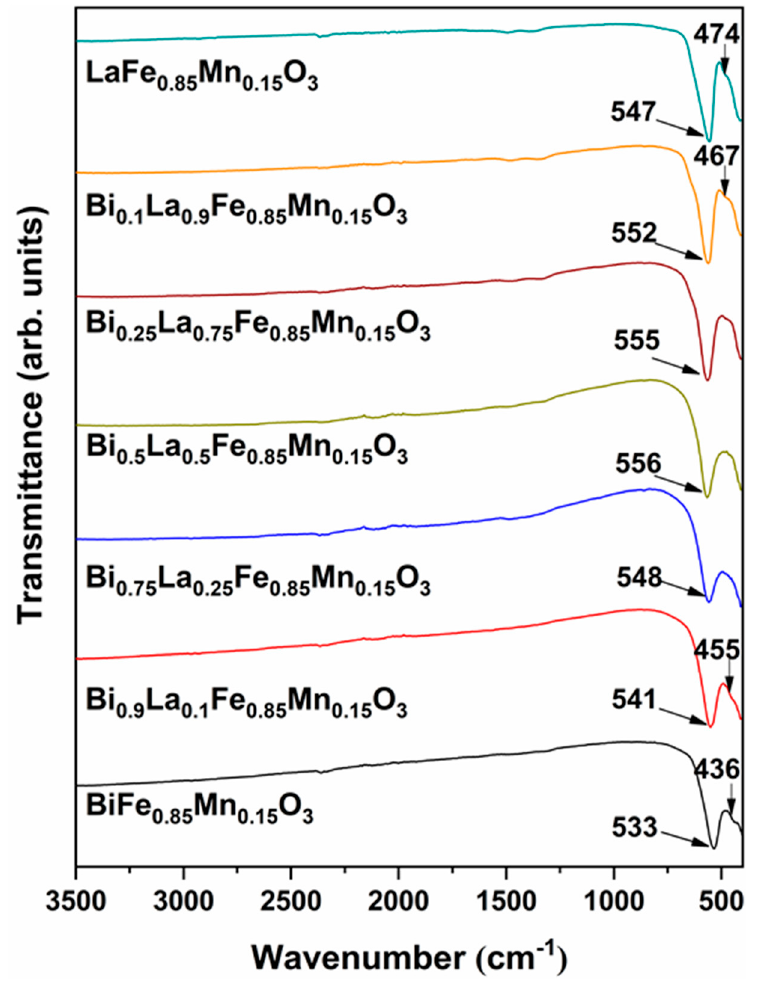
Figure 4. FT-IR spectra of Bi 1-x La x Fe 0.85 Mn 0.15 O 3 samples.